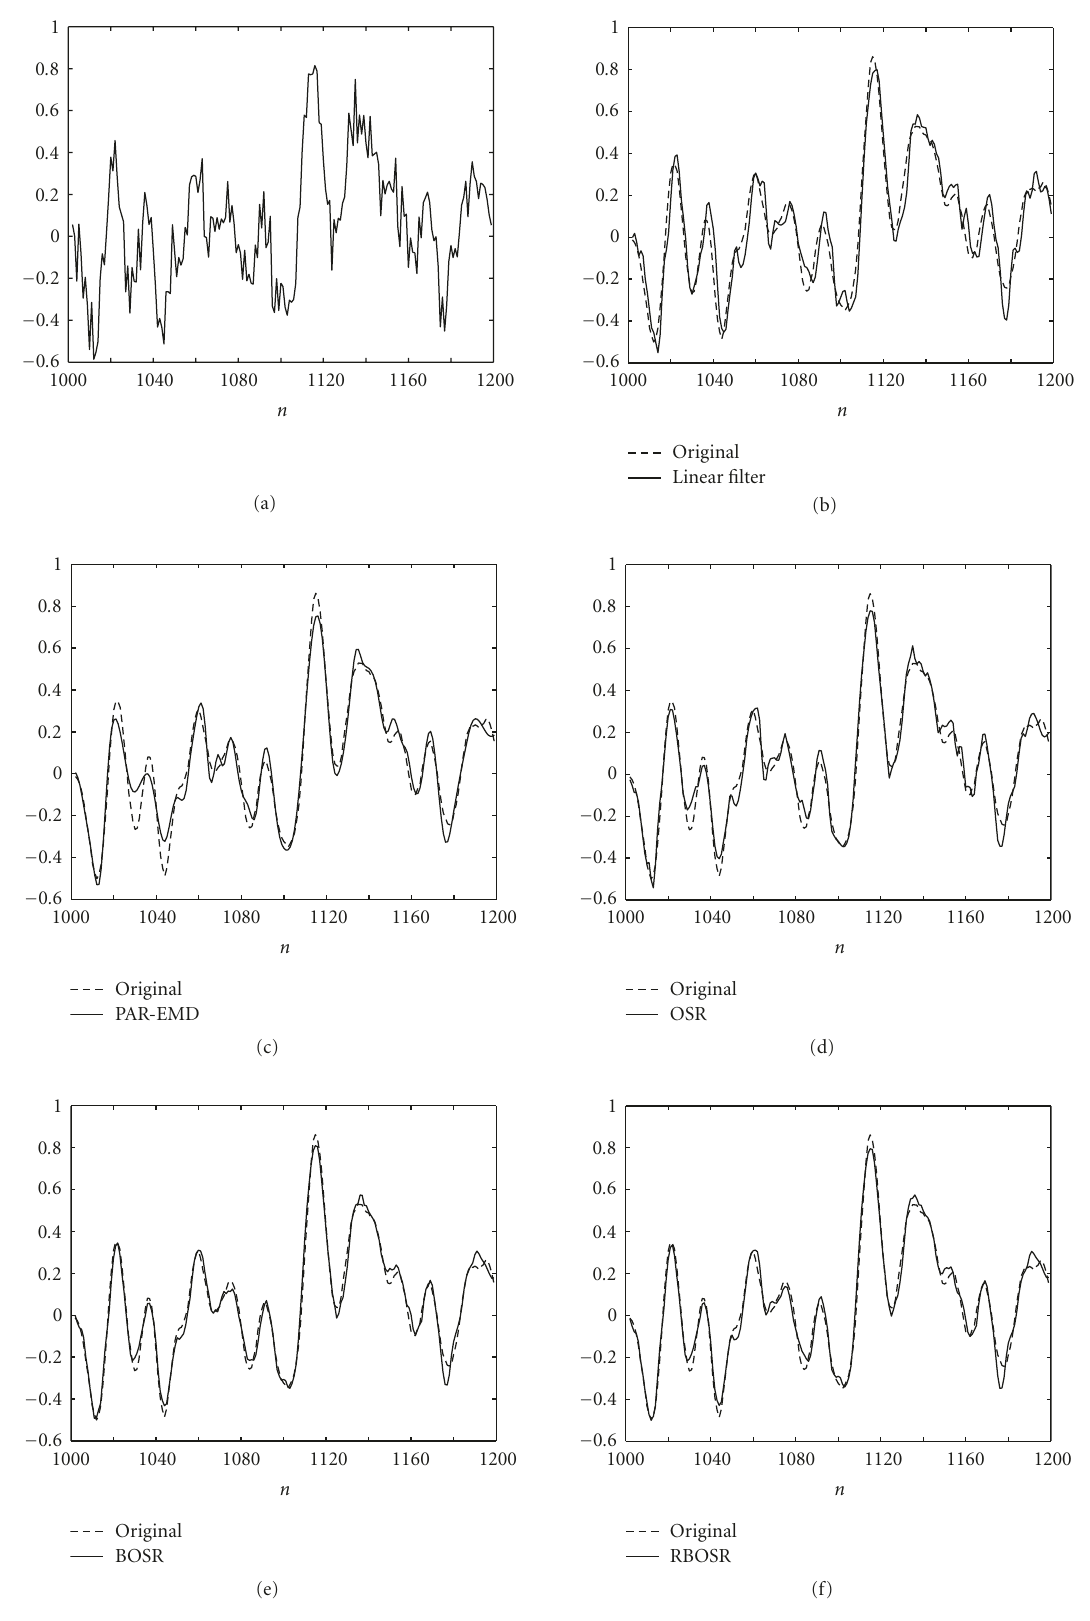
Figure 4: Denoising performance. Shown in dash lines are the original signal and the solid lines are denoised signals. (a) Noisy signal, (b) linear Butterworth filter, (c) PAR-EMD, (d) OSR, (e) BOSR, (f)